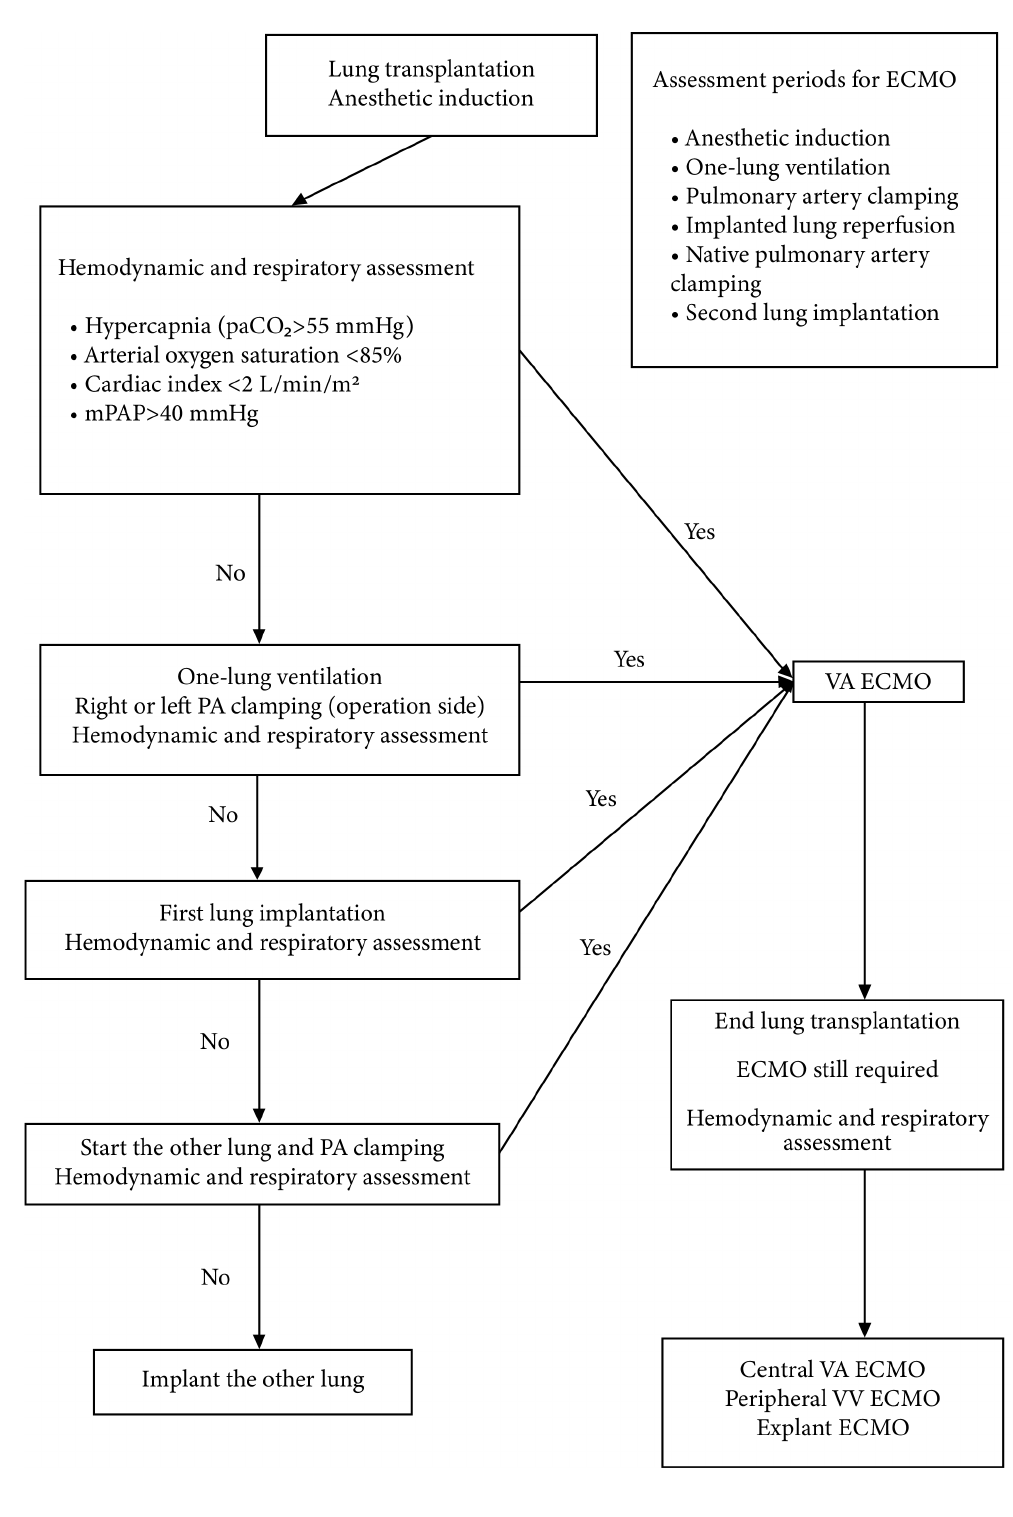
Fig. 1 - Algorithm for the use of intraoperative